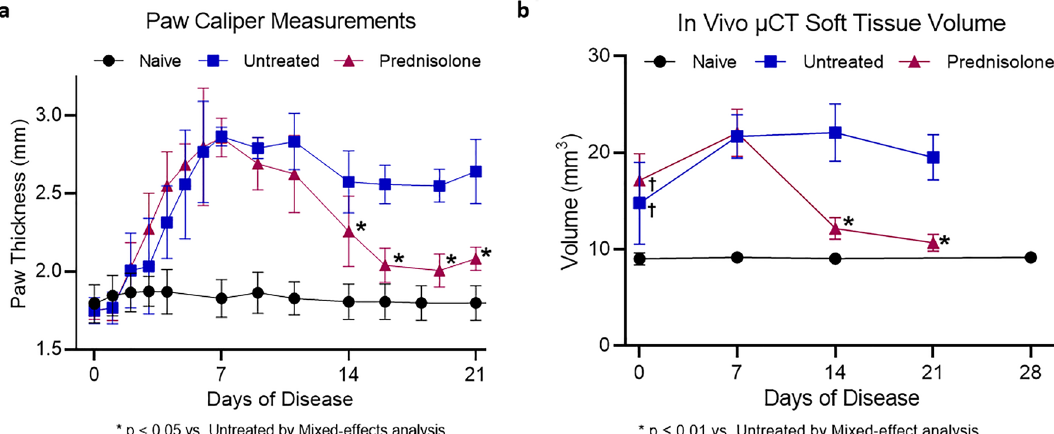
Figure 3. ( a ) Paw caliper measurements provide a quick readout of paw inflammation longitudinally, shown here in terms of change in paw thickness with n = 15 for the naïve group and n = 6 for the untreated and prednisolone groups . ( b ) In vivo µCT imaging measures the volume of soft tissue in the tarsal region as a marker of paw inflammation. This readout is expressed here in terms of soft tissue volume longitudinally, where the untreated and prednisolone groups have n = 6. The naïve group has n = 15 on Day 0 and n = 10 on Days 7, 14, and 21.